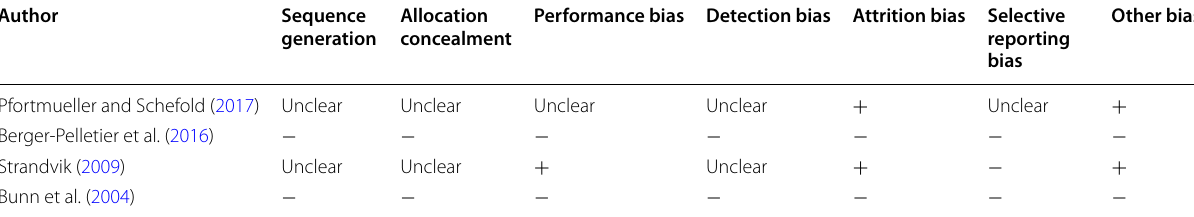
Table 2 Assessment of risk of bias of all included